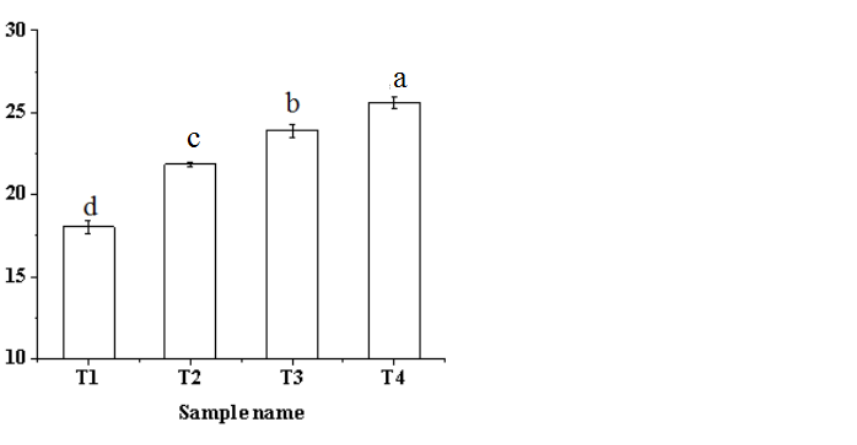
Figure 4. Effects of ultrasound-assisted sodium bicarbonate treatment on the active sulfhydryl of raw pork myofibrillar protein. T1, sodium bicarbonate 0 g, ultrasound time 0 min; T2, sodium bicarbonate 0.2 g, ultrasound time 0 min; T3, sodium bicarbonate 0.2 g, ultrasound time 30 min; T4, sodium bicarbonate 0.2 g, ultrasound time 60 min. Each value represents the mean ± SE, n = 4. a–d Different parameter superscripts indicate significant differences ( p < 0.05).